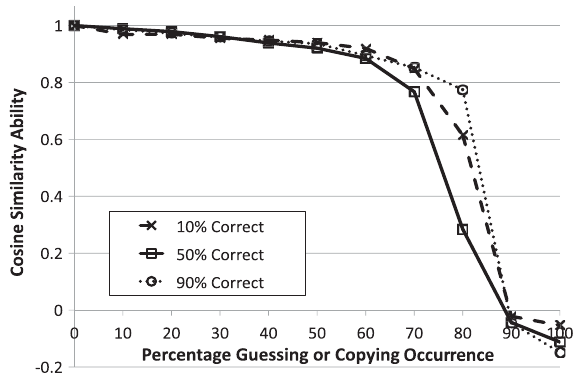
FIG. 10. Cosine similarity of the learner abilities from the “ clean ” exam values as a function of simulated copy or guess occurrence. Values are shown for a success rate of 10% ( “ educated guessing ” ), 50%, and 90% ( “ copying ”